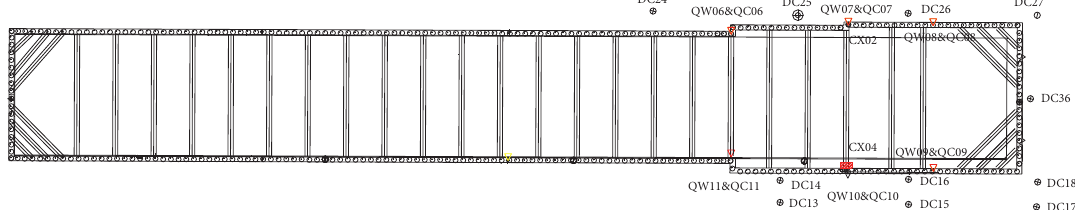
Figure 15: Monitoring point layout of station deep foundation pit.